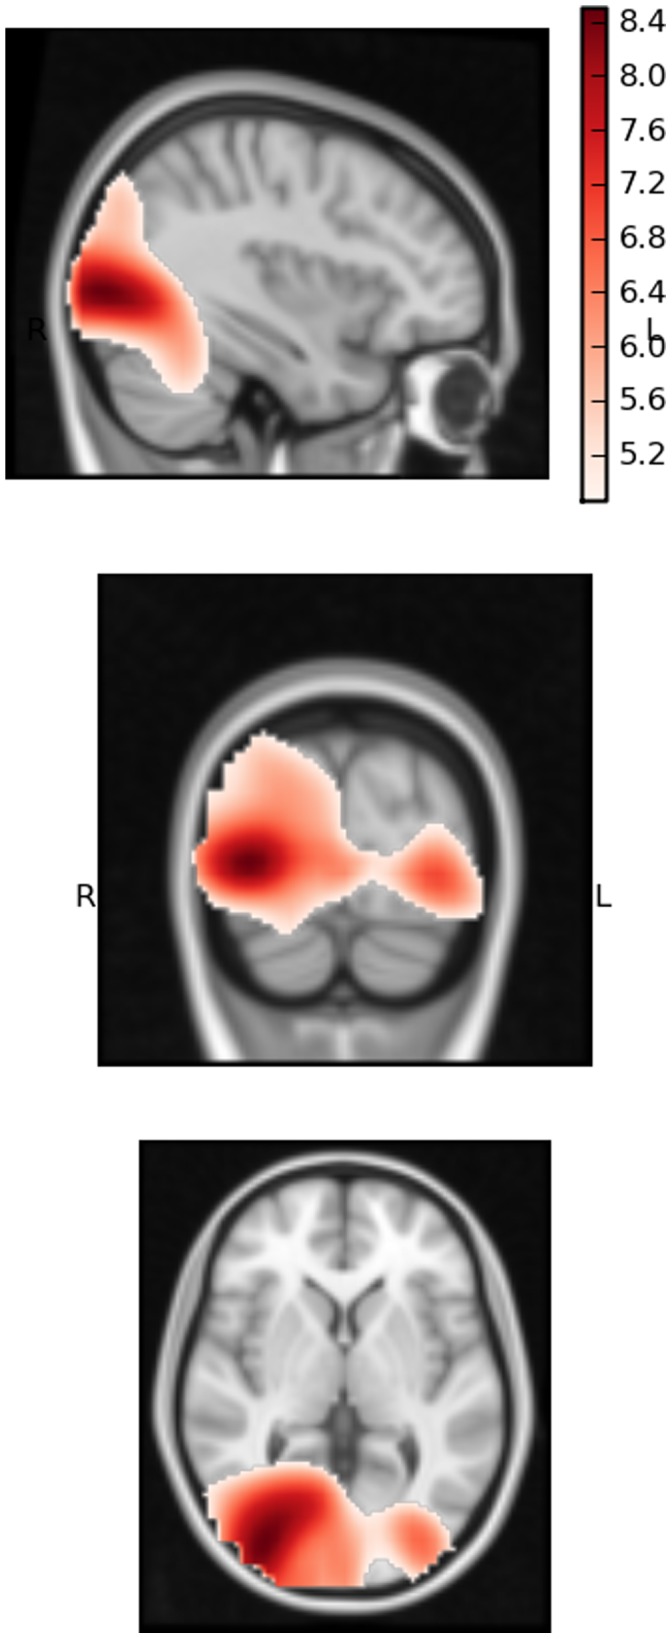
Significant differences in gamma band (30–80
Hz) response, 250–450
ms, between ASD and TD participants. Red  =  TD > ASD; Blue  =  ASD > TD; p<.001 for all highlighted voxels. Slice shown MNI: −36, −86, 2 (voxel of maximum difference).